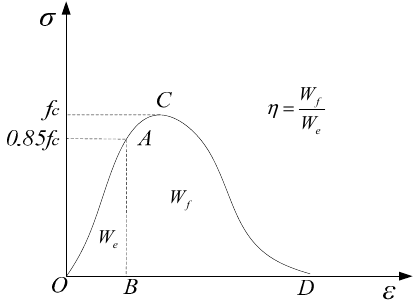
Figure 17. Diagram of the toughness index of concrete.